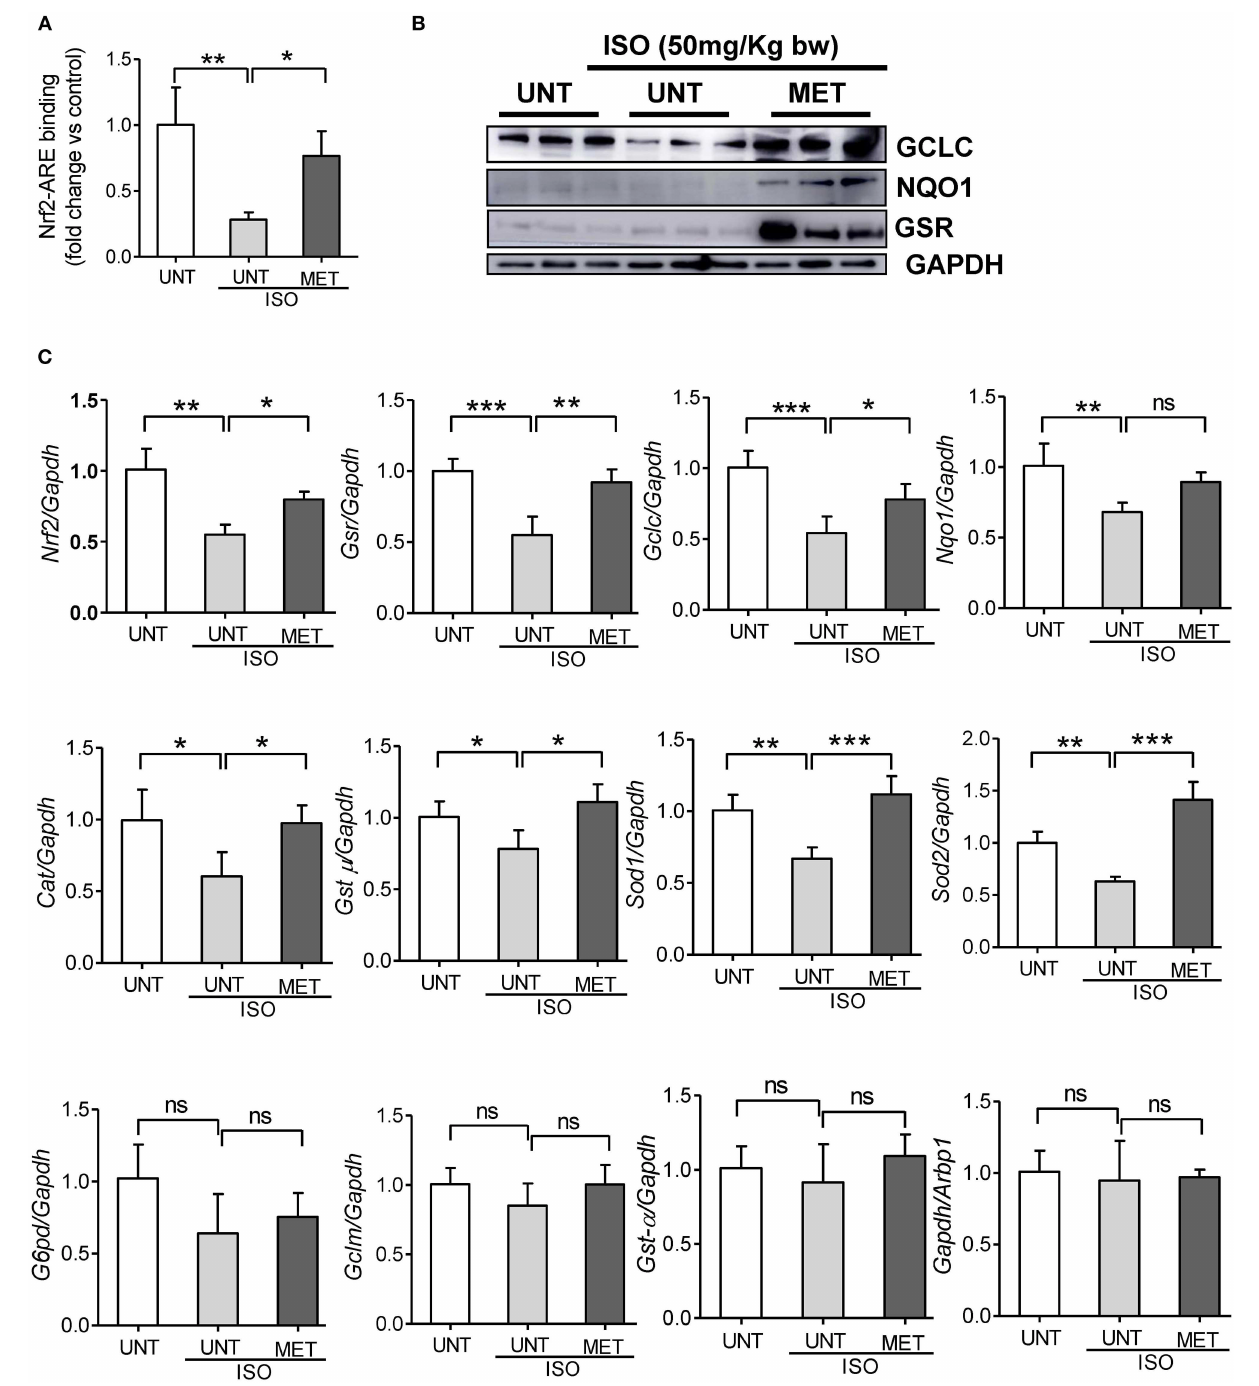
FIGURE 4 | Exercise stabilized the Nrf2 binding activity and antioxidant gene expression in the heart of Isoproterenol treated mice. (A) Nrf2-ARE binding activity was measured in heart nuclear lysates of untrained control, untrained + ISO and trained + ISO mice using Active motif TransAM Nrf2 assay kit ( n = 4–6/group), (B) Immunoblots for key antioxidants using cytosolic heart extracts of UNT, UNT-ISO and MET-ISO mice ( n = 6/group). (C) Antioxidant gene levels were determined using gene specific primers by qPCR and relative gene expression was analyzed by normalizing with Gapdh/Arbp1 , n = 4–6/group, values are represented as mean ± SD. Significance: * p < 0.05 ; ** p < 0.01 ; *** p < 0.001; ns, no